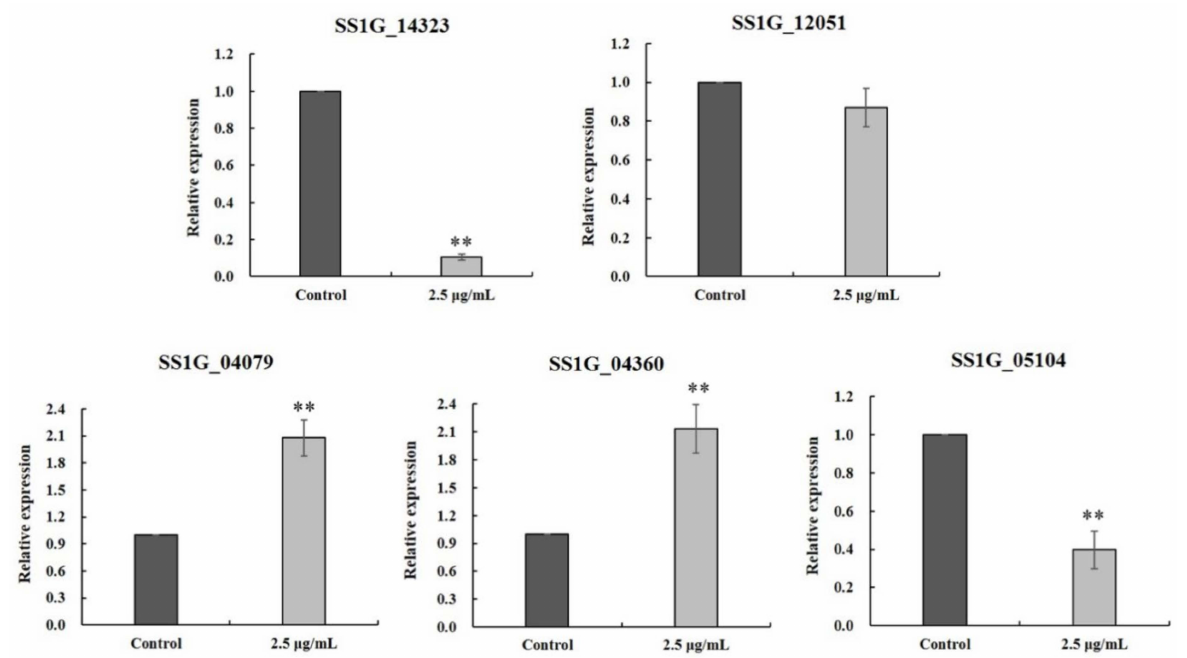
Figure 7. Verification of DEGs by RT-qPCR. Data are displayed as the mean ± SD, bars with the ** indicate very significant differences according to Duncan’s test ( p <